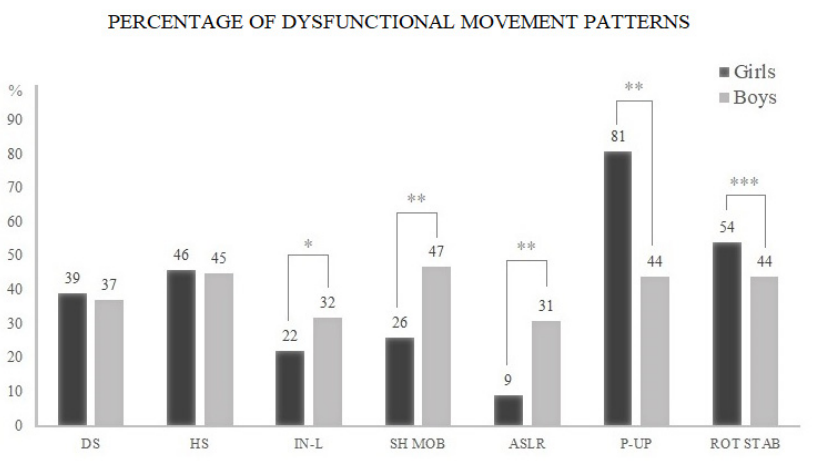
Figure 2. Proportion (%) of adolescent girls and boys who performed dysfunctional movement (DFM)